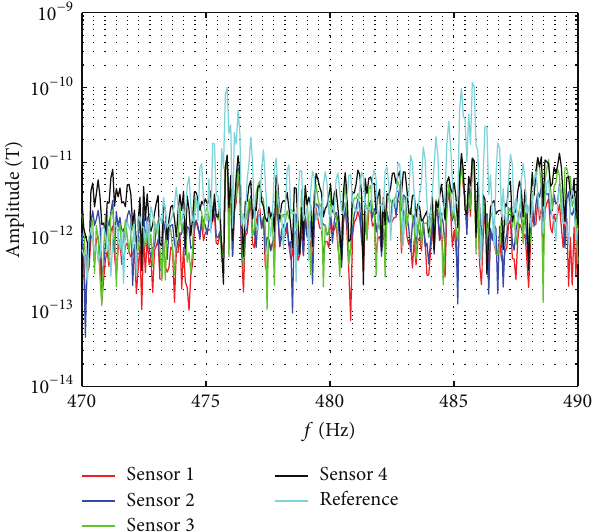
Figure 5: Frequency-domain waveforms of the received signals (three noise